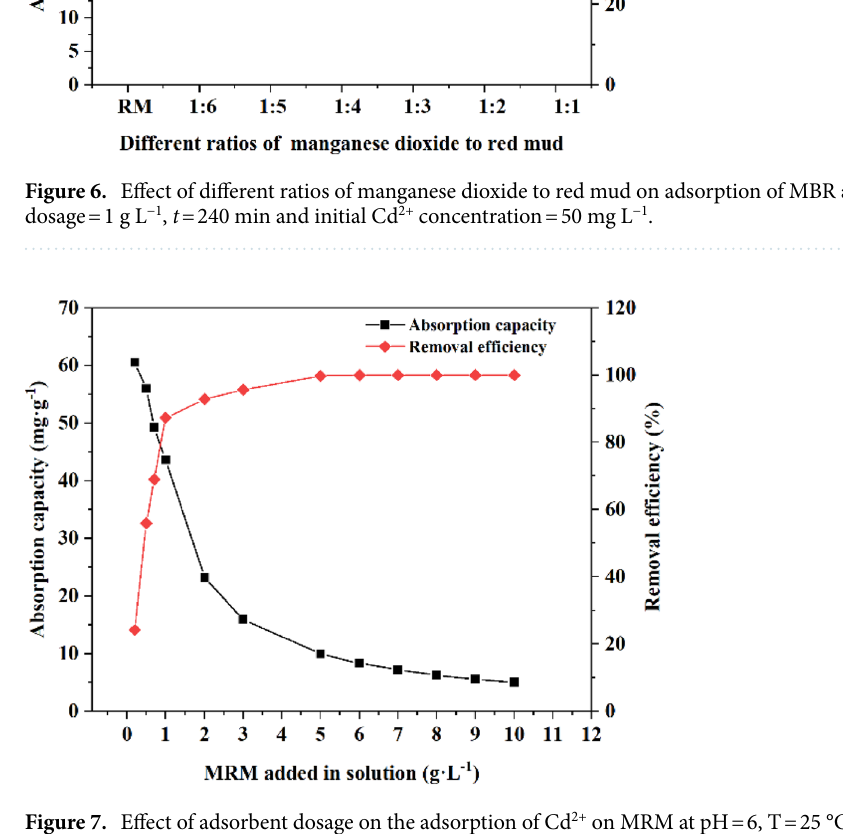
Figure 7. Effect of adsorbent dosage on the adsorption of Cd 2+ on MRM at pH = 6, T = 25 °C, t = 240 min and initial Cd 2+ concentration = 50 mg L −1